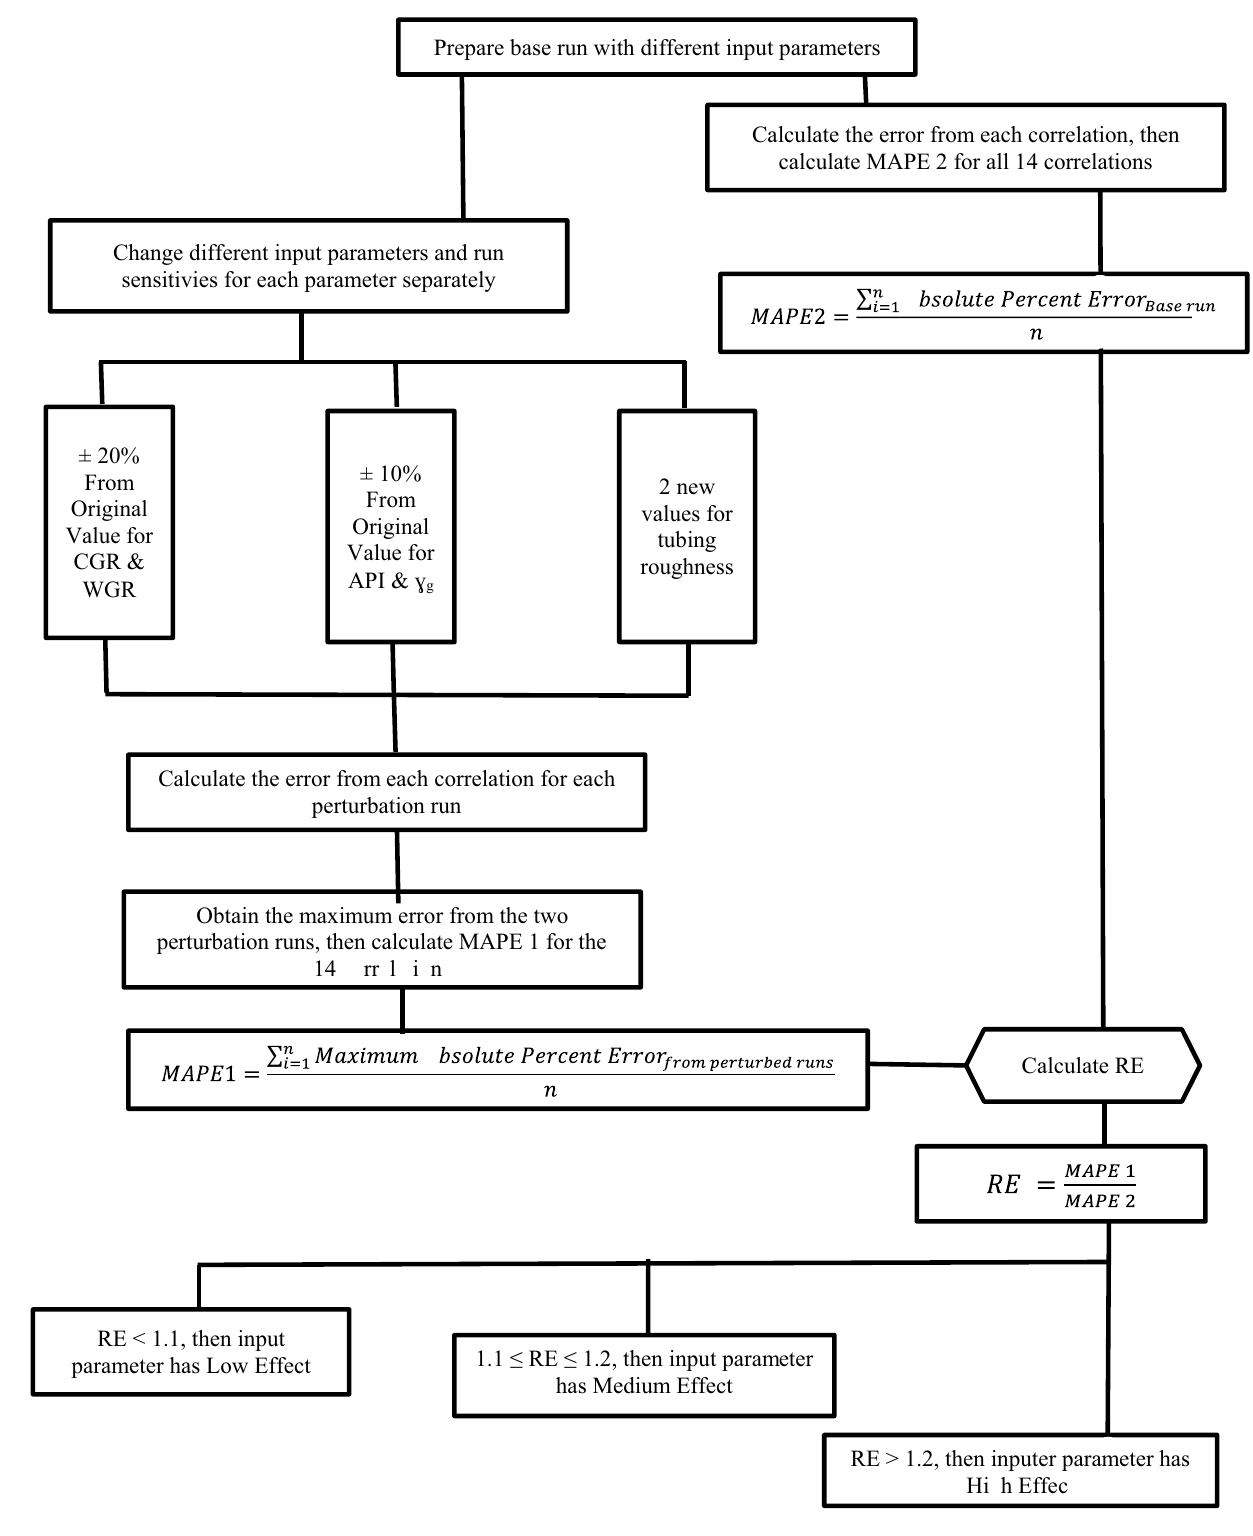
Fig. 13 Effect of input parameters on the maximum absolute error for each correlation relative to actual